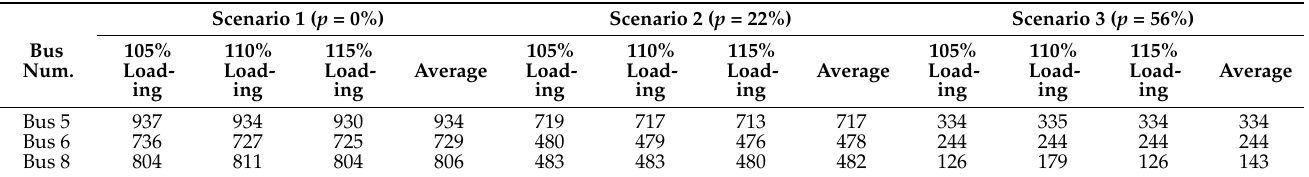
Table 2. Fault Level MVA obtained from the Load Change-based Thevenin Impedance.